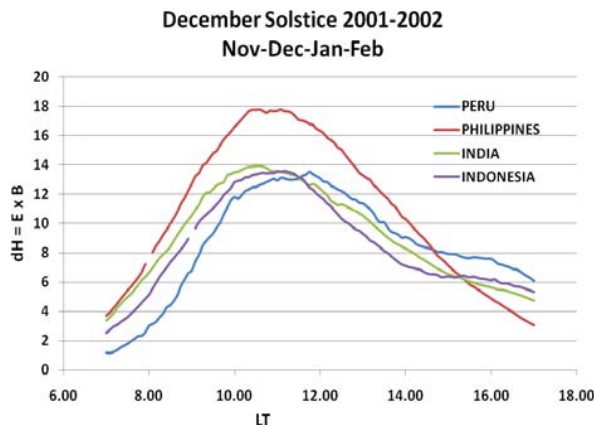
Fig. 5a. Same as Fig. 3a for December solstice. Figure 5a. Same as Figure 3a for December Figure 5b. Same as Figure 3b for solstice. December solstice.